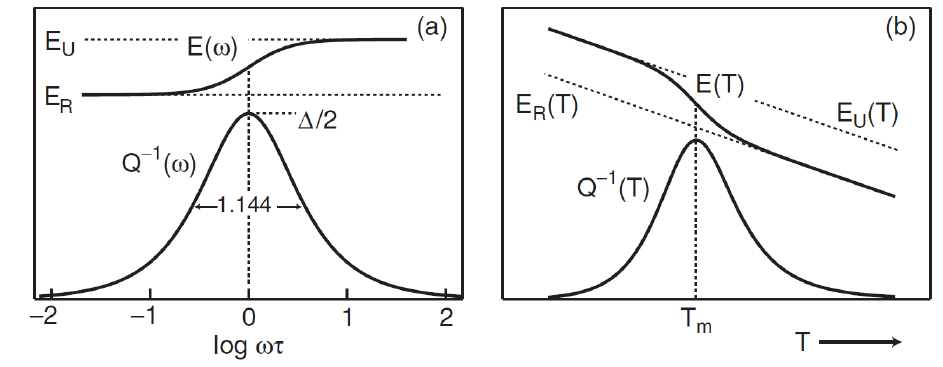
Figure 4. Dynamic modulus E and internal friction Q − 1 of the standard anelastic solid [101]: ( a ) as a function of frequency on a log ωτ scale and ( b ) as a function of temperature at constant frequency. In the latter case, the relaxation-induced step in E(T) is superimposed on the intrinsic temperature dependence of EU(T) and ER(T).